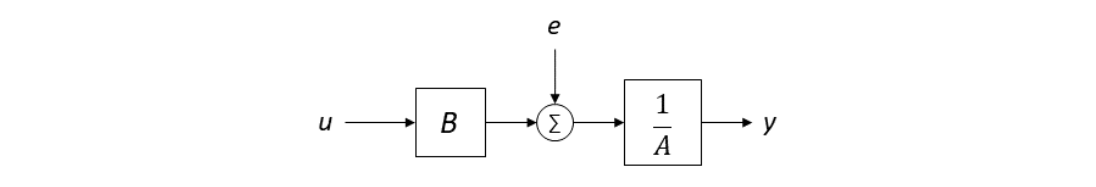
Figure 2. Simple graphical representation for an auto-regressive with exogenous input (ARX)